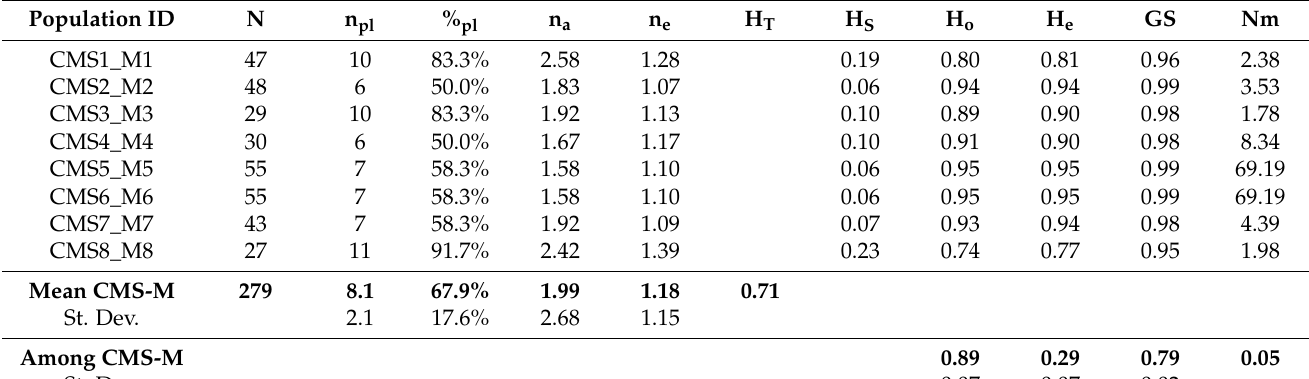
Table 4. Descriptive statistics for all SSR loci for CMS-M groups. The number of individuals (N), number (n pl ) of polymorphic loci, percentage (% pl ) of polymorphic loci, mean number of observed (n a ) alleles per locus, mean number of effective (n e ) alleles per locus, total (H T ) genetic variability, within (H S ) genetic variability, observed (H o ) homozygosity, expected (H e ) homozygosity, Rohlf’s simple matching genetic similarity (GS) coefficient and gene flow estimates (Nm). The mean values within population (Mean CMS-M) and the mean values calculated considering all the possible pairwise comparisons among the CMS-M groups were